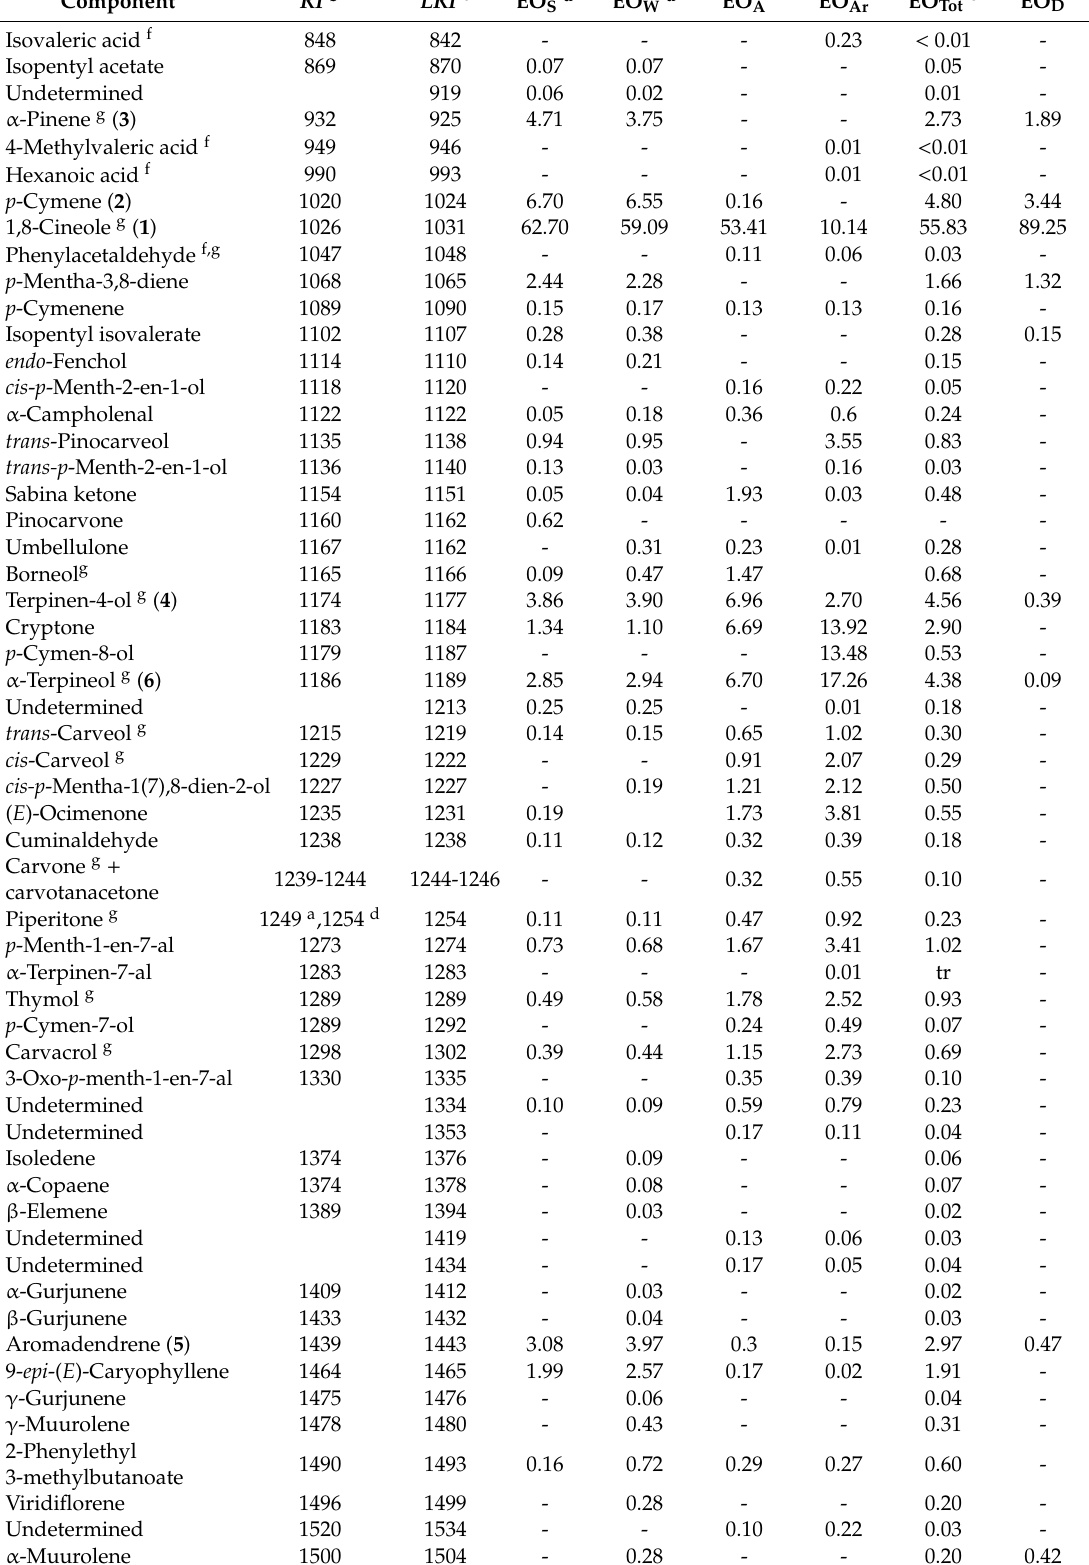
Table 1. Chemical components and their percentages (%) in the di ff erent volatile fractions (EO) isolated from E. camaldulensis leaves a